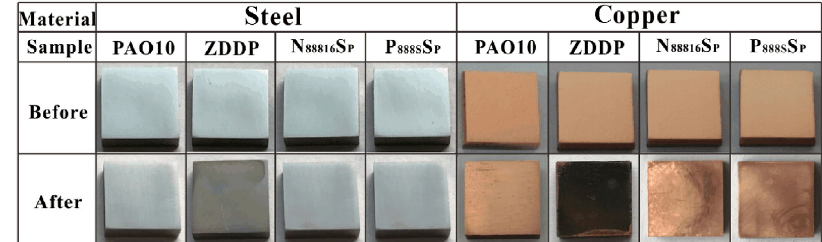
Fig. 8 Photographs of steel discs and copper pieces before and after corrosion tests at 120 ° C for 5